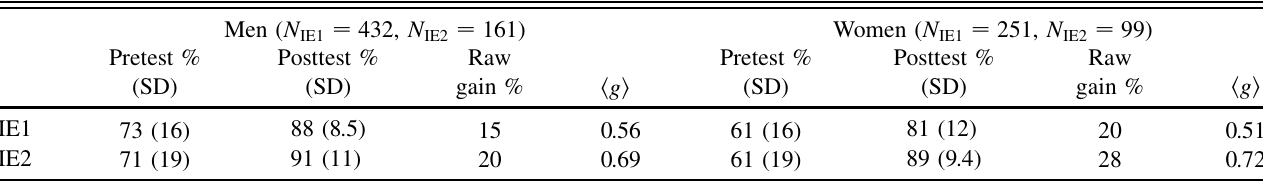
TABLE I. Summary of data from Lorenzo et al. where the normalized gain is h g i ¼ ð posttest (cid:1) pretest Þ = ð 100 (cid:1) pretest Þ . Men ( N IE1 ¼ 432 , N IE2 ¼ 161